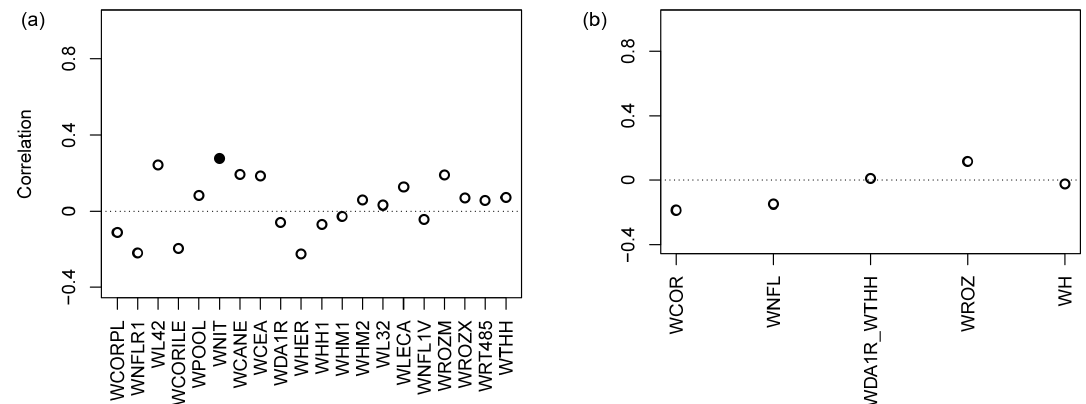
Figure 3. Pearson correlation coefficients between tree-growth observations and simulations at the Eastern Canadian taiga sites (Fig. 1) with MAIDEN using NRCAN (5arcmin) as climatic inputs (Table 2) for the 1950–2000 period with QC_taiga calibrated parameters from Gennaretti et al. (2017). Individual (a) and aggregated sites (b) . White inner circles stand for non-significant correlations ( p value > 0.05). Plain circles stand for significant correlations ( p value <